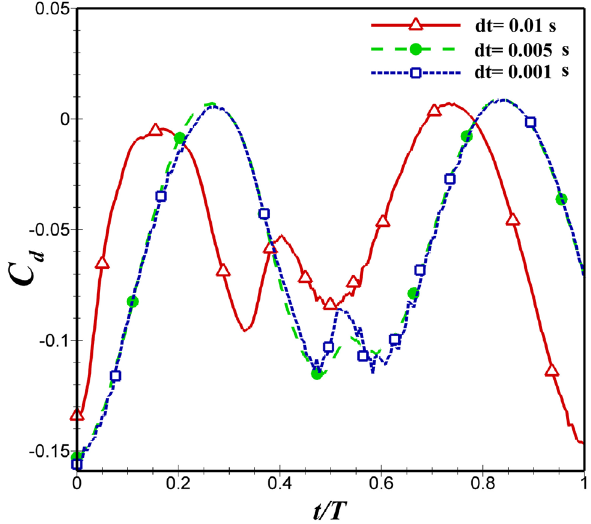
Figure 6. Drag coefficient variations versus time for different grids with close-up views.